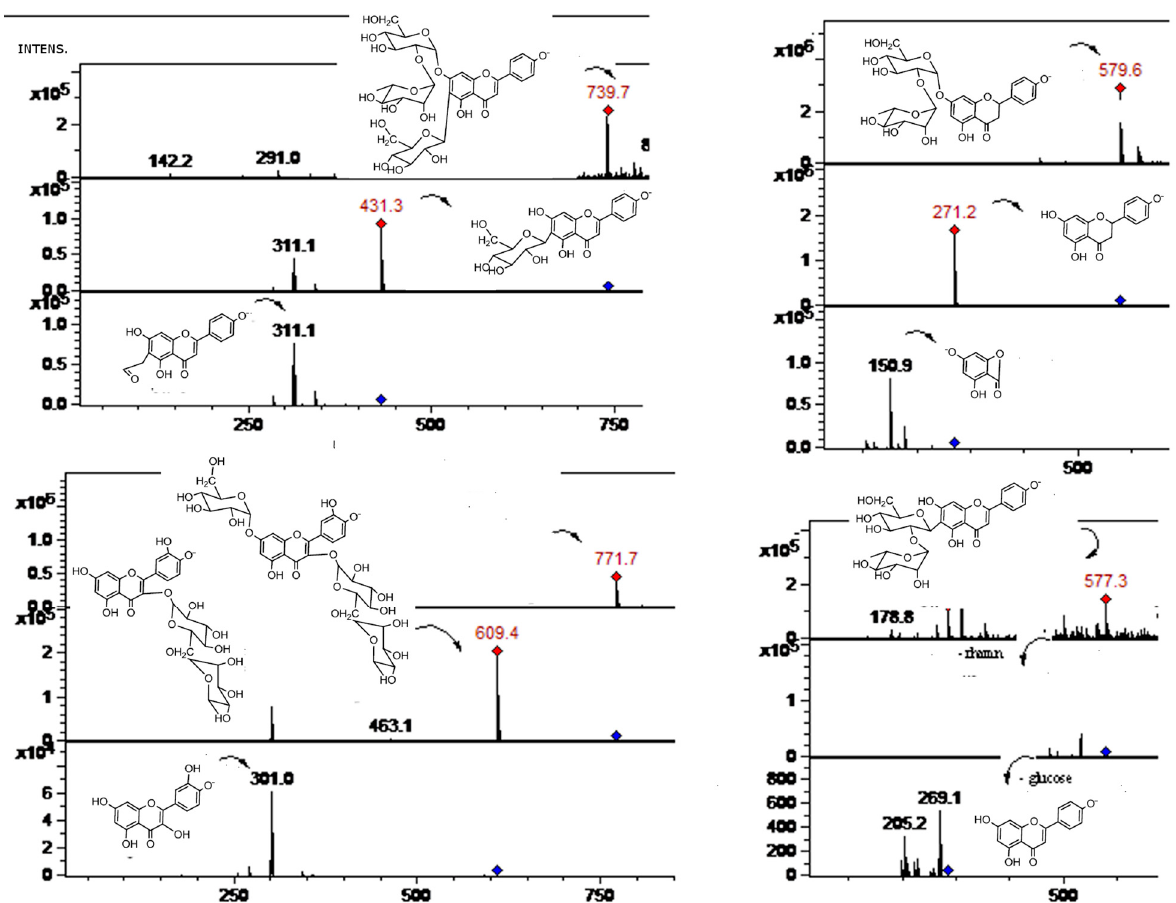
Figure 5. MS spectra of peaks 2 , 4 , 12 , and 28 . (Refer to Table 1).